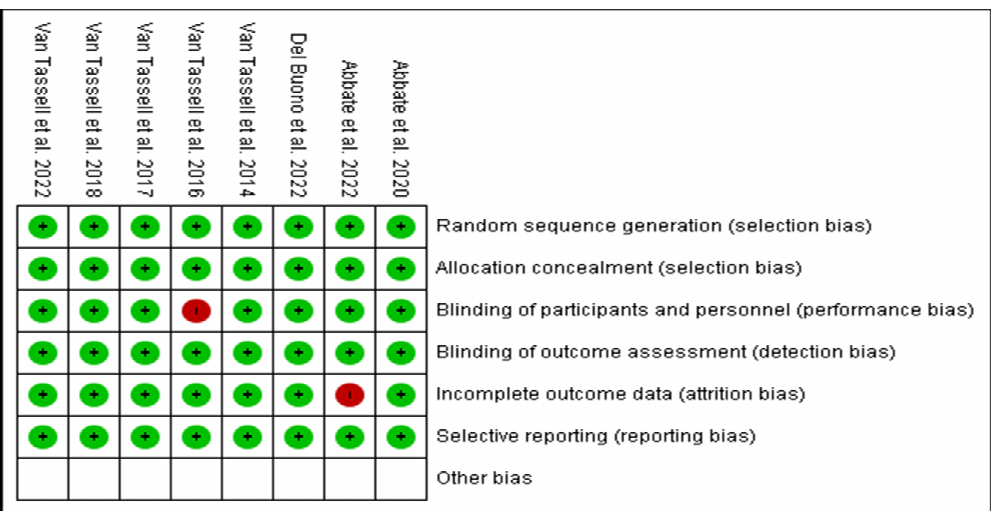
Figure 3. Depicting the risk of bias graph judgments for the six items.